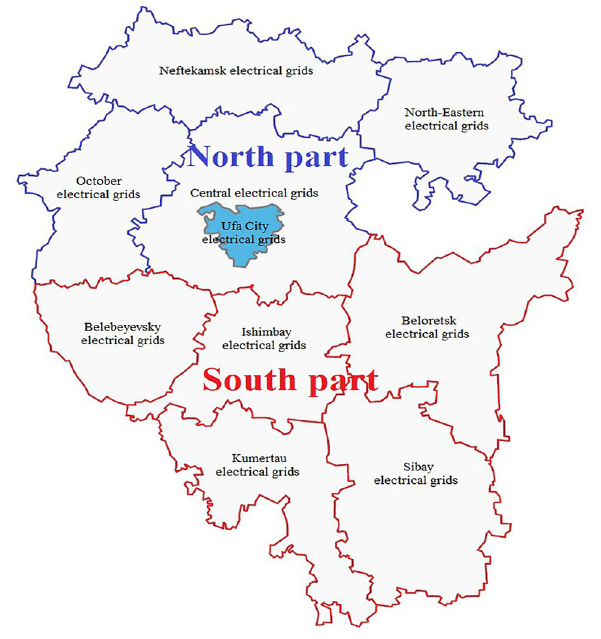
Fig. 2 Power distribution zone OOO